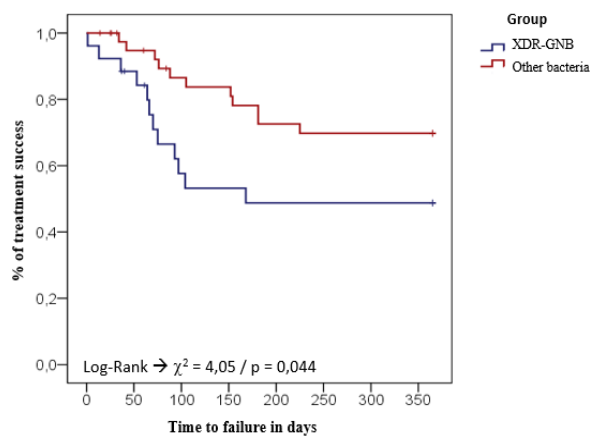
Figure 1. Kaplan–Meier survival curve for treatment failure (death/recurrence) considering PJIs caused by XDR-GNB and other bacteria.